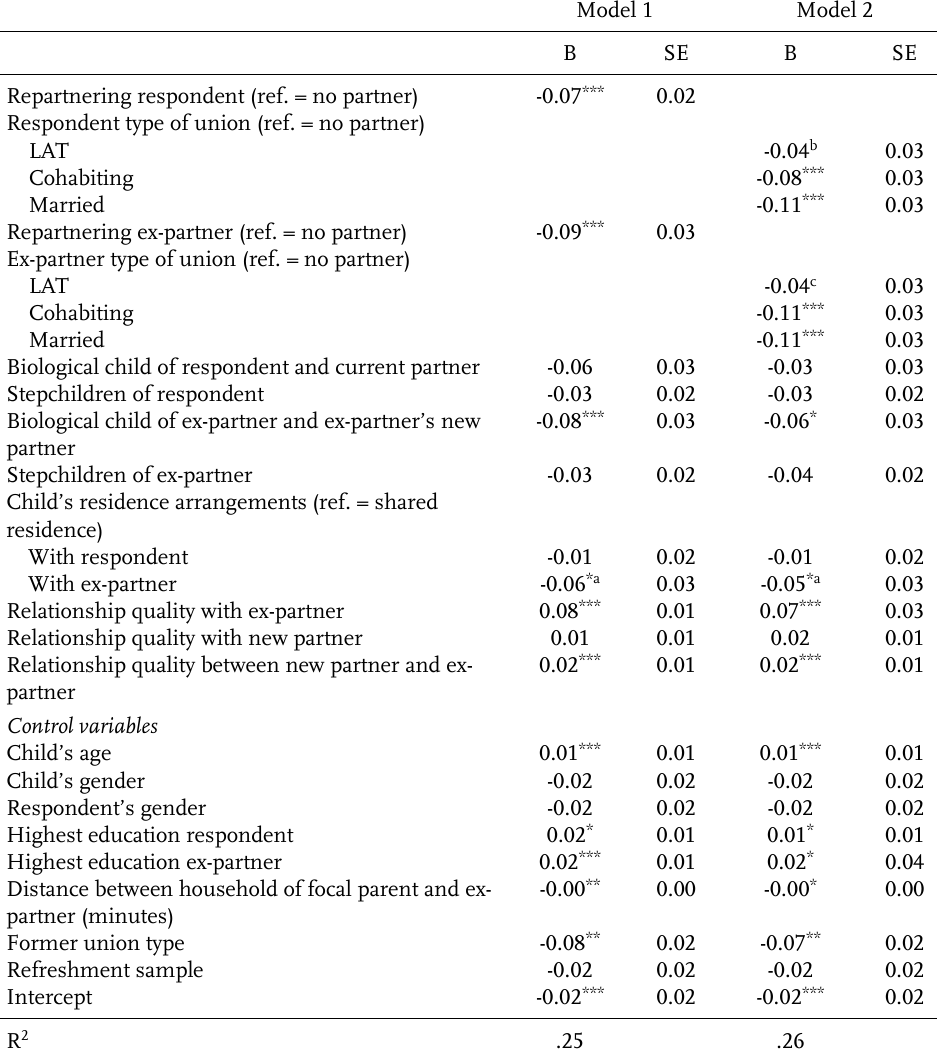
Table 2: Summary of linear probability models predicting the ex-partner’s attendance at child’s last birthday